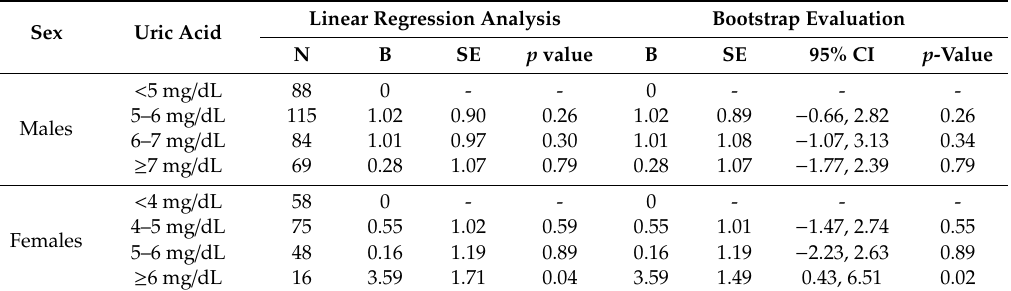
Table 2. Association between serum uric acid levels and FEV1 / FVC in males and females,